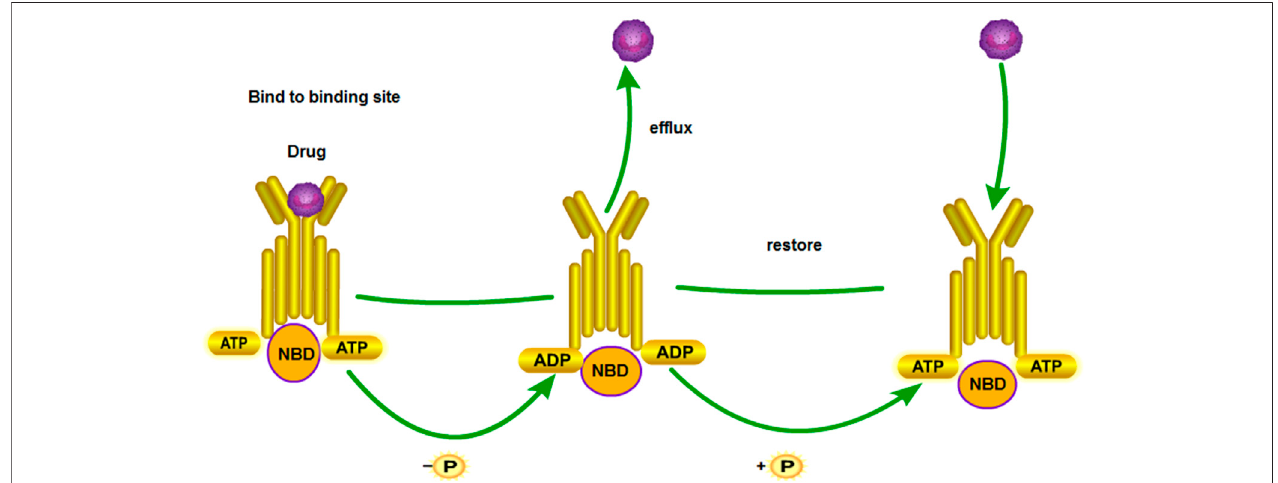
FIGURE 5 | MDR1 drug transport mechanism. NBDs are nucleotide-binding domains. The substrate enters inside the protein. ATP binds to the binding site of NBD. ATP releases energy to change the conformation of transmembrane proteins and releases drugs out of the cell membrane. Subsequently, the next ATP is hydrolyzed to restore protein conformation. The above process is repeated.